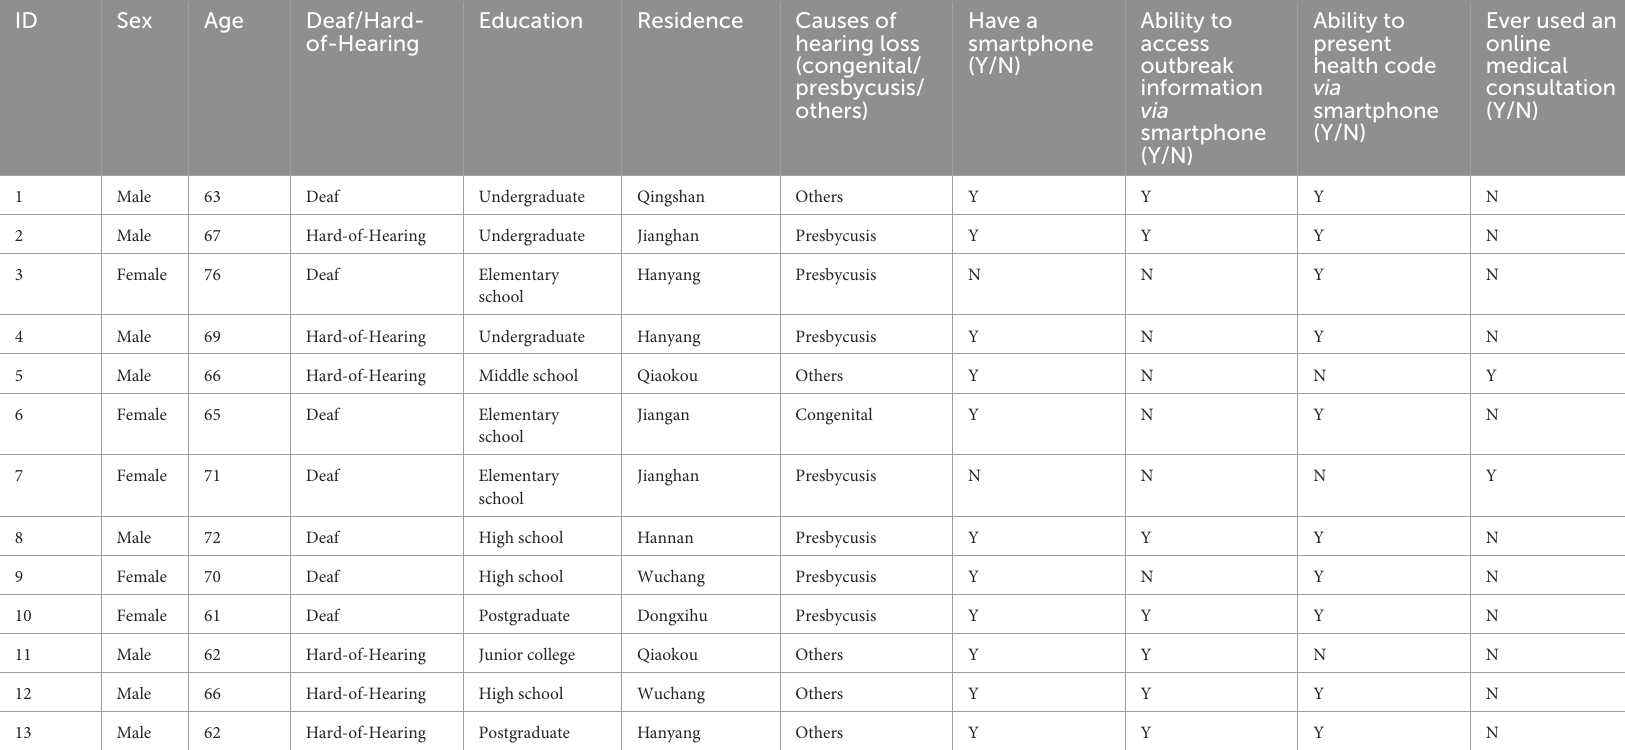
TABLE 1 Basic characteristics of